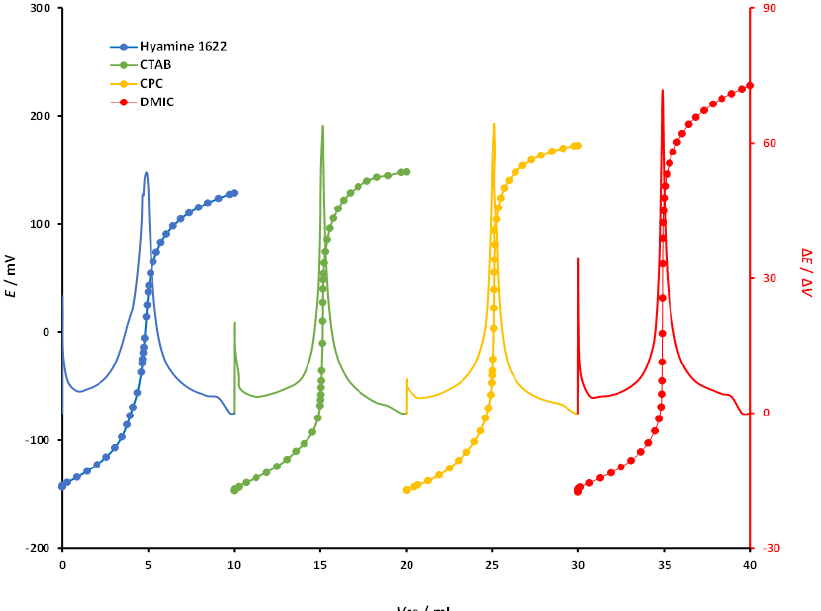
Figure 5. Potentiometric titration curves, and first derivatives, of SDS (0.4 mM) with four different cationic surfactants (0.4 mM) used as a titrant: Hyamine 1622, CTAB, CPC, and DMIC. The titration curves and their first derivatives were rearranged for the sake of clarity. Table 4. Potentiometric titration results of SDS and DBS anionic surfactants with selected